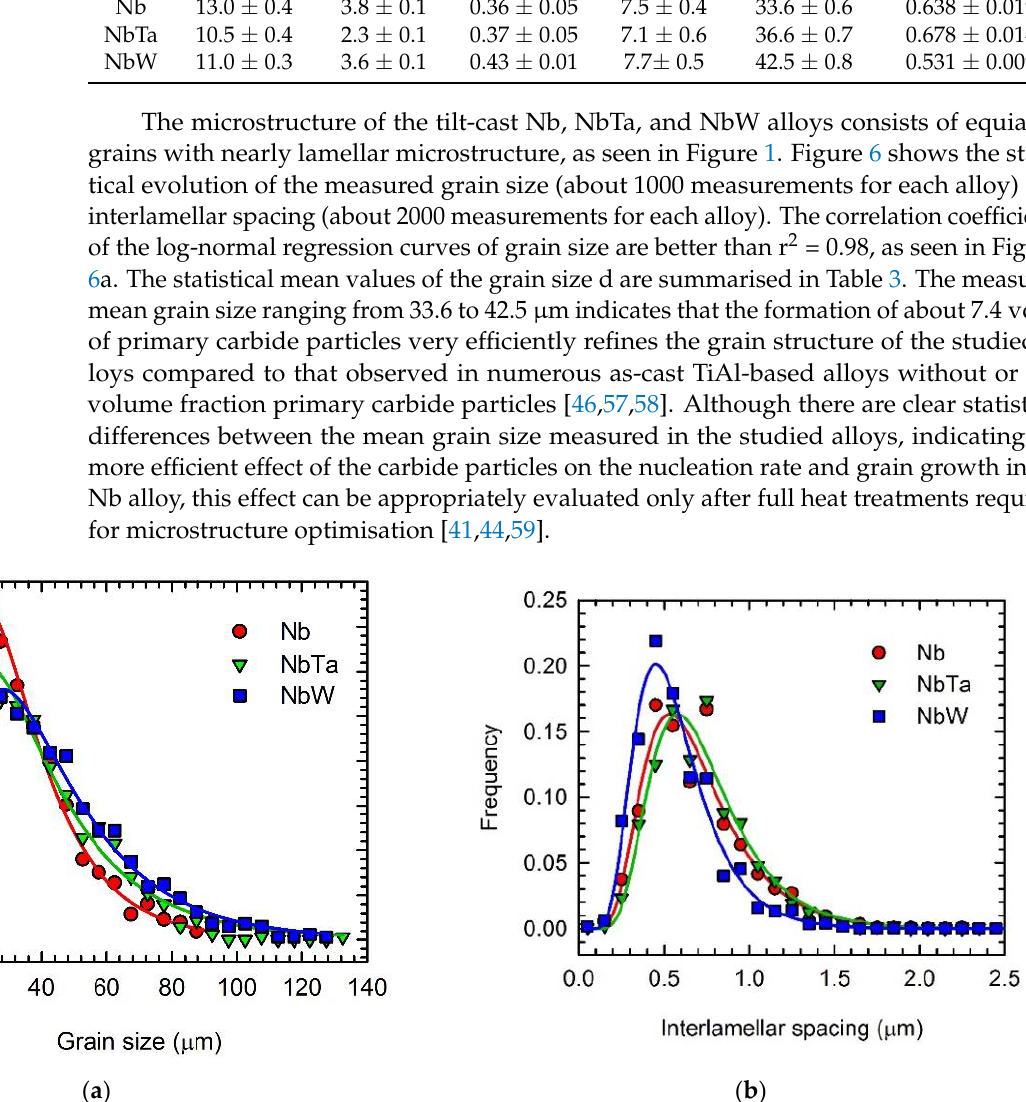
Table 3. Measured microstructural parameters of the tilt-cast Nb, NbTa, and NbW alloys. Alloy